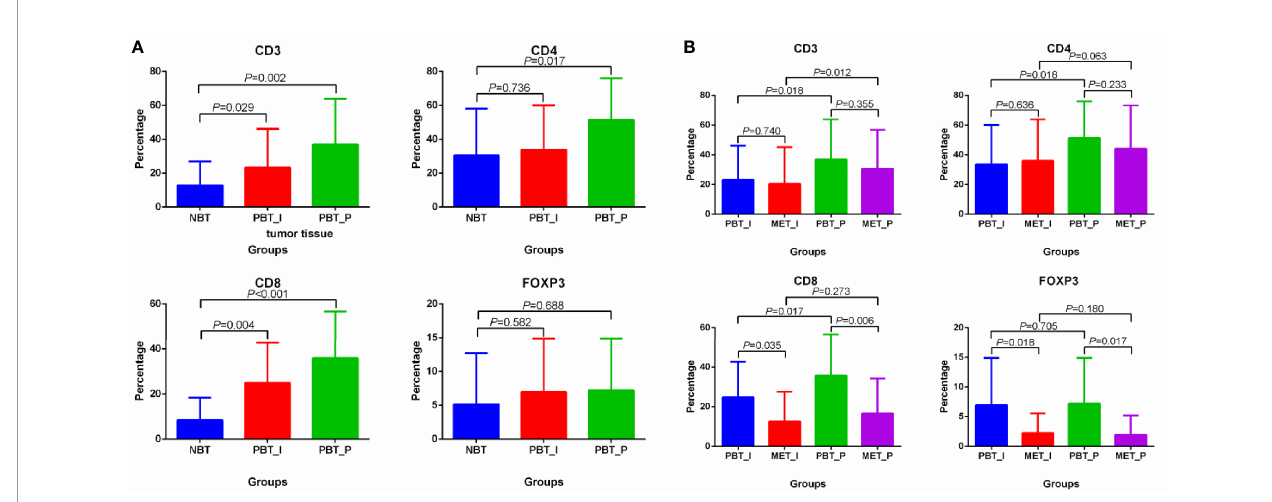
FIGURE 4 | Differential distribution of CD3, CD4, CD8 and FOXP3 in matched normal breast tissues, primary cancers and oligometastatic lesions in TNBC and HER2+ breast cancer. (A) Differential distribution of CD3, CD4, CD8 and FOXP3 in normal tissue and primary lesions. (B) Differential distribution of CD3, CD4, CD8 and FOXP3 in primary and metastatic lesions. NBT, normal breast tissue; PBT_I, intratumoral regions of primary breast tissue; MET_I, intratumoral regions of oligometastatic lesions; PBT_P, peritumoral regions of primary breast tissue; MET_P, peritumoral regions of oligometastatic